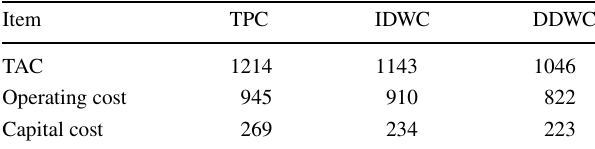
Table 2 Summary of TAC of three F–T heavy oil separation